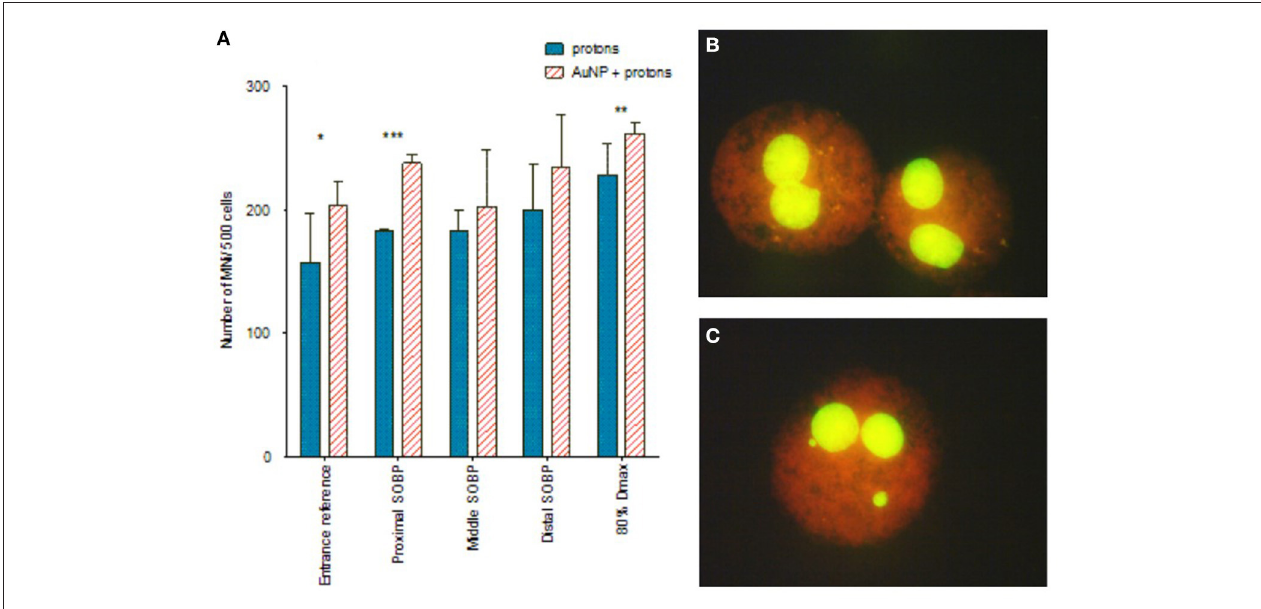
FIGURE 5 | (A) The effect of protons and AuNPs on the MNi expression of CHO-K1 cells. Where (*) denotes p < 0.05, (**) = p < 0.01 and (***) = p < 0.001. (B) Binucleated cells without MNi (proton alone). (C) Binucleated cells containing MNi (protons + 50nm AuNPs). The plotted values in the graph represent the average number of MNi/500 BN cells and the respective standard deviation of three biological repeats. Created with Biorender.com.